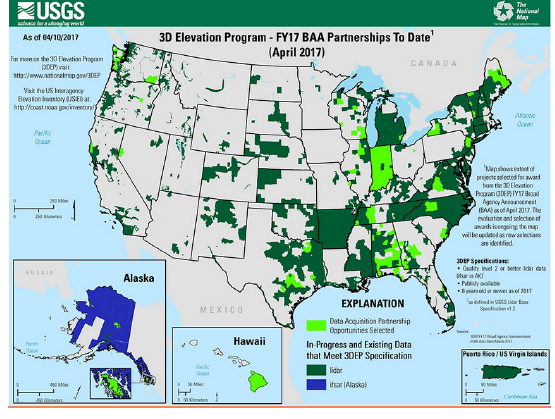
Figure 1: NED data source